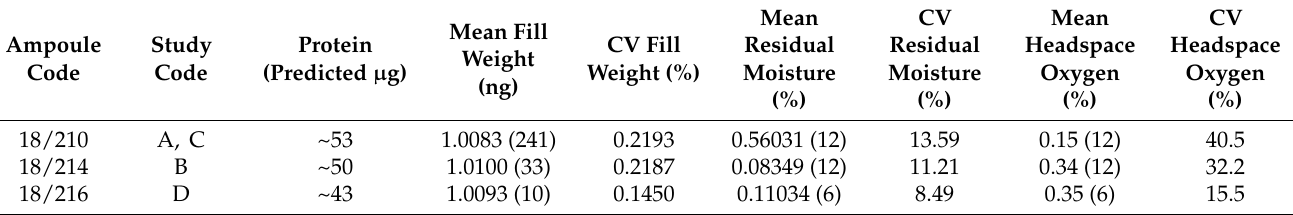
Table 3. Mean fill parameters of final lyophilized Bevacizumab